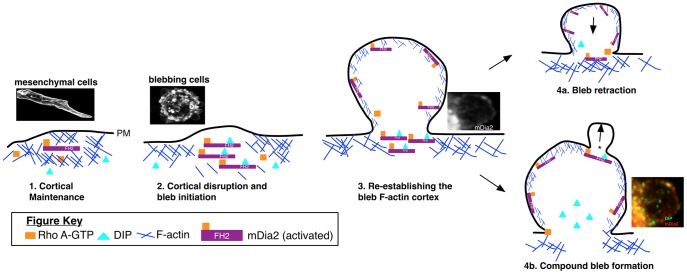
mDia2:DIP-driven mechanism for bleb and lobopodia formation: bulbous structures driving amoeboid motility in 3D matrices.1. Cortical Maintenance: activated mDia2 maintains the F-actin cortex underlying the plasma membrane (PM); 2. Cortical disruption and bleb initiation: DIP binding to the mDia2 FH2 domain disrupts F-actin assembly and bundling, initiating cortical weakening and bleb expansion; 3. Re-establishing the bleb F-actin cortex: Upon bleb expansion, mDia2 enters the bleb and through interaction with activated Rho GTPases, re-establishes the F-actin cortex underlying the bleb; and 4a. Bleb retraction ensues, driven, in part, by ROCK and myosin-based contractility; 4b. Compound bleb formation: DIP binding the mDia2 FH2 domain at the rim of the bleb (noted as * in the inset) initiates a secondary break in the bleb cortex, leading to compound bleb, or lobopodia formation.